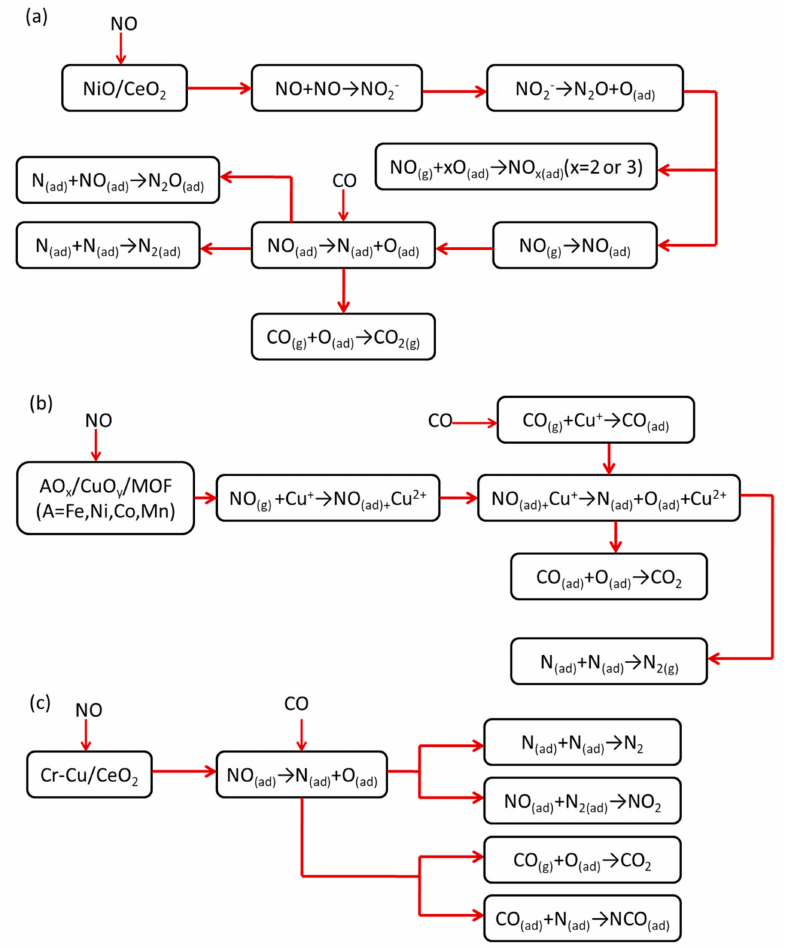
Figure 3. Schematic illustration of possible NO+CO reaction mechanism over ( a ) Ni/CeO 2 , ( b ) AOx/CuOy/MOF (A = Fe, Ni, Co, Mn), and ( c ) Cr-Cu/CeO 2